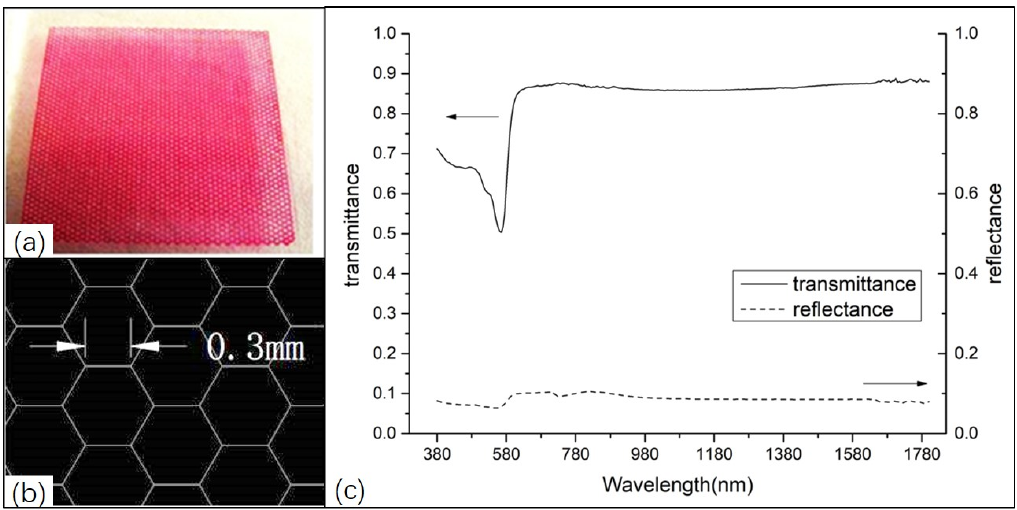
Figure 1. The halftone coating: ( a ) a coated glass sample; ( b ) the details of mesh texture; ( c ) the spectroscopic test results of coated glass samples.